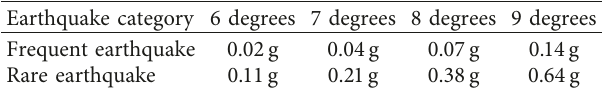
Table 12: Basic earthquake acceleration value in Chinese